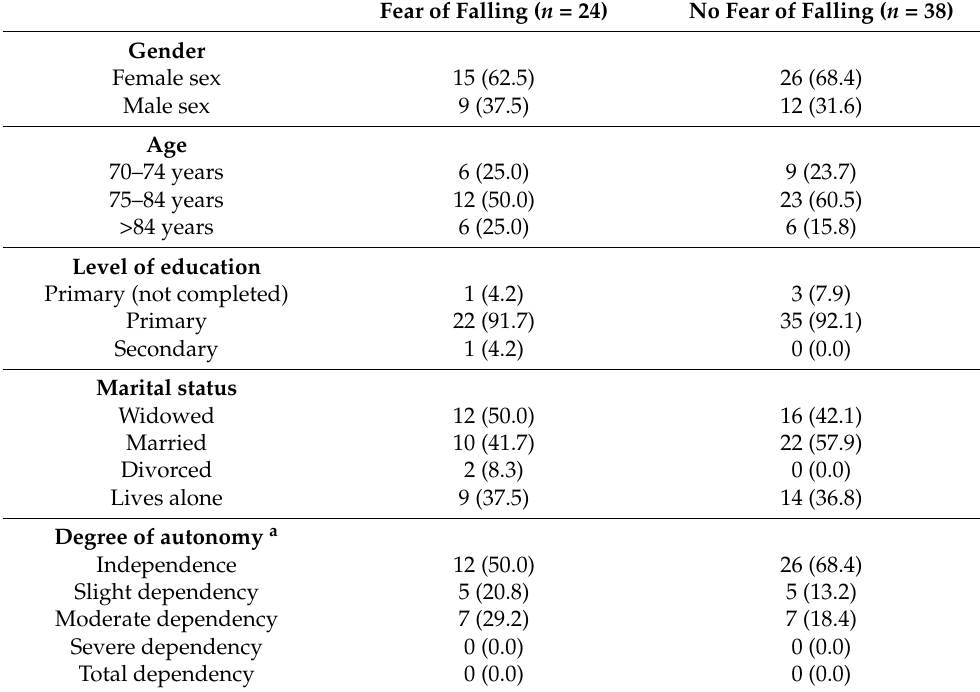
Table 2. Socio-demographic and clinical characteristics of study participants based on the presence of fear of falling, n